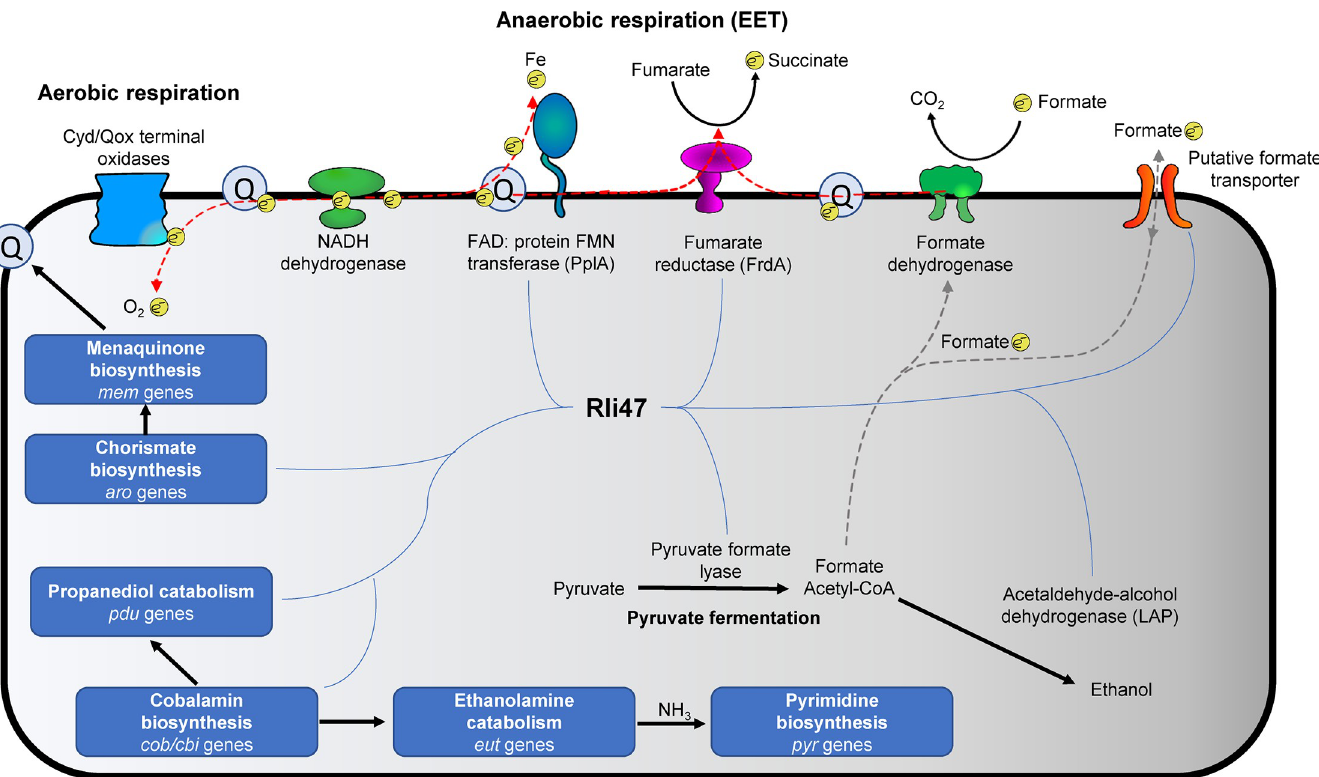
Fig 5. Proposed model of differentially expressed metabolic systems of L . monocytogenes 6179 during co-cultivation with cheese rind bacteria and their relation to Rli47. Bold indicates major metabolic and respiratory pathways. Gray dashed lines represent the hypothesized flow of formate, and blue paths show systems possibly regulated by Rli47 based on data from a number of recent studies [64, 83–85, 89]. Red dashed lines represent electron flow through proteins and the cellular membrane, and electrons are denoted by e - . Q represents membrane-bound menaquinone involved in electron shuttling.